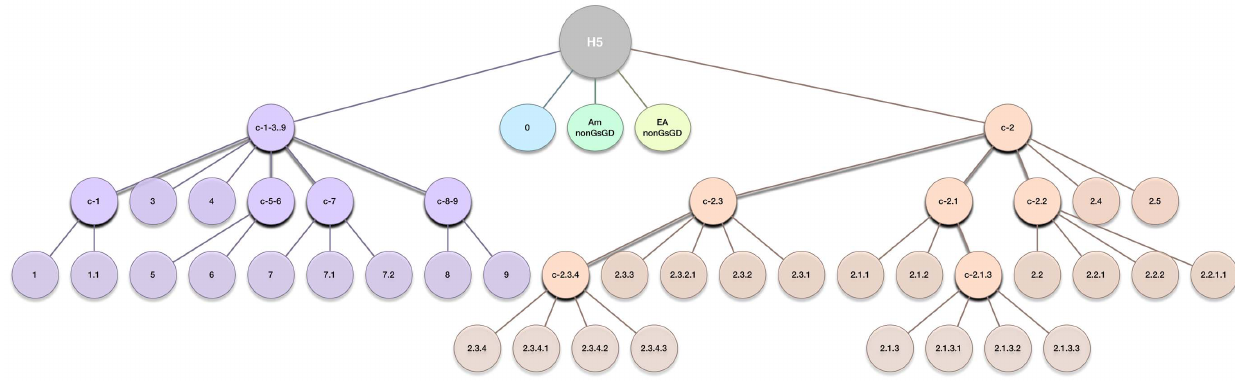
Figure 1. Annotation tree for LABEL’s H5N1 annotation module. Each internal node corresponds to an annotation level (classification step) within the hierarchical annotation process. Accordingly, HMM profiles and SVM classes used by the H5 module are represented by all non-root nodes (color circles). The ‘‘c- X ’’ notation stands for ‘‘cluster X ,’’ where X is some general group of clades. Exact correspondence with the H5N1 clade clustering [5] is not preserved in the annotation tree for the sake of algorithmic